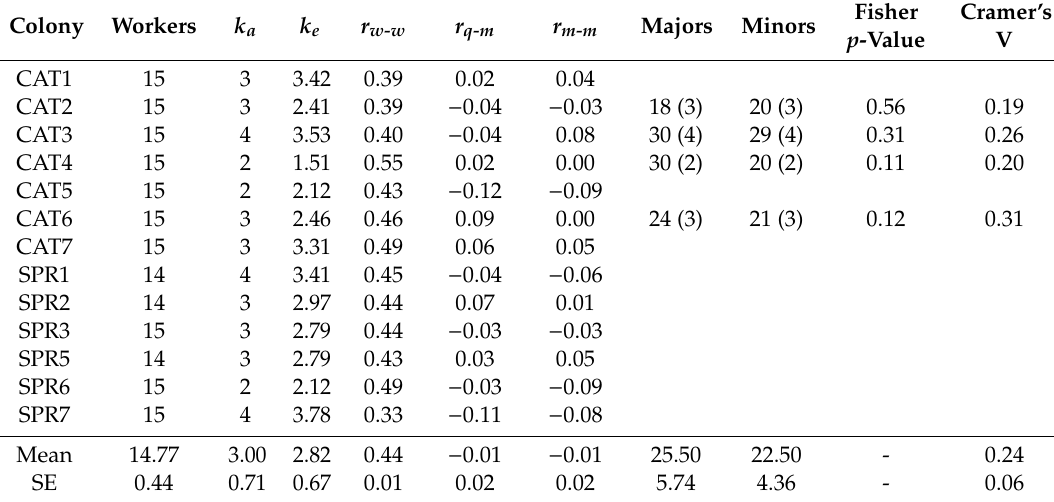
Table 1. Mating system, colony and population genetic structure, and worker subcaste determination in Melophorus bagoti. The table indicates, for each colony, the number of workers genotyped to determine colony and population genetic structure; the absolute ( k a ) and e ff ective ( k e ) mating frequency of the queen; relatedness among nestmate workers ( r w-w ), the queen and her mates ( r q-m ), and the queens’ mates ( r m-m ). Also given, for the subcaste-specific analyses, are the number of major and minor workers that were genotyped as well as the Fisher p -values and Cramer’s V values. The mean Fisher p -values were calculated by combining the data from the four colonies included in this analysis. The numbers of patrilines identified from the genotypes are in